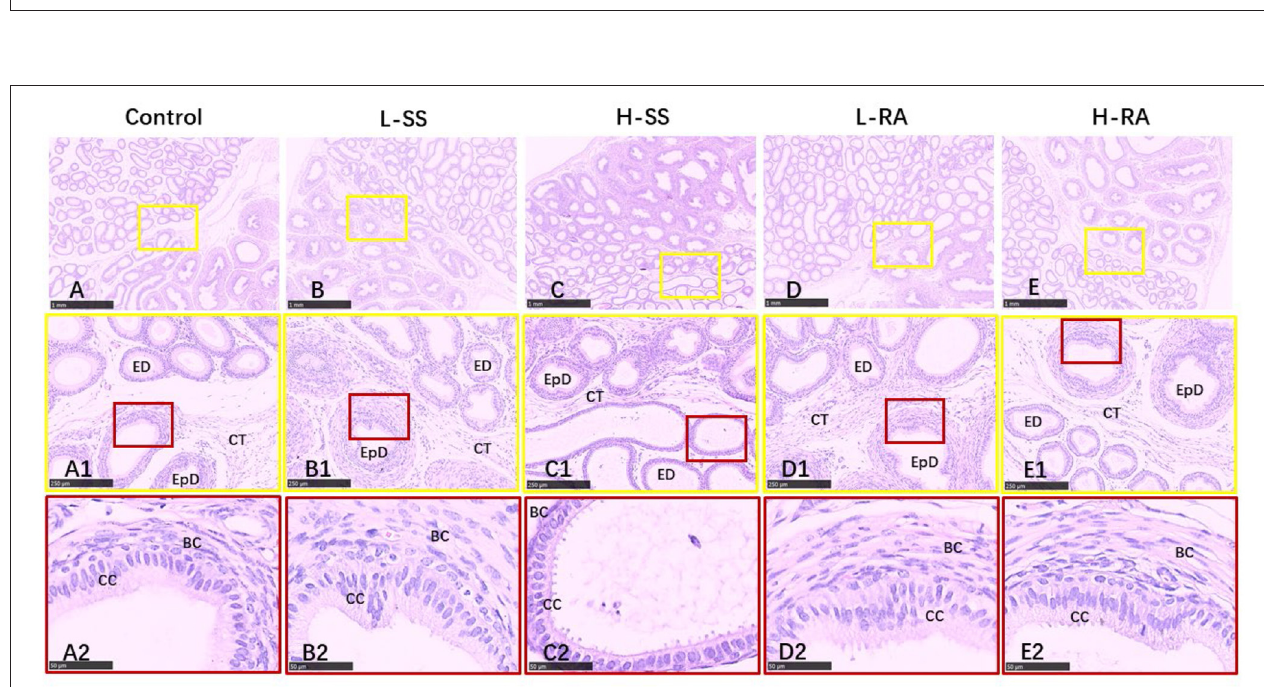
FIGURE 5 | Effect of dietary non-nutritive sweetness drinking on histologic changes in the epididymis in male guinea pigs. Animals in the control, L-SS, H-SS, L-RA, and H-RA groups were supplied water solution with normal water, 1.5mM sodium saccharin, 7.5mM sodium saccharin, 0.5mM rebaudioside A, and 2.5mM rebaudioside A for 28 days, respectively. Tissues were sectioned at 4 µ m and stained with H&E. Graphs in small colored square boxes are enlarged below. ED, efferent duct; EpD, epididymis ductus, CT, connective tissue; CC, ciliated cell; BC, basal cell. Bars = 1,000 µ m (A–E) , 250 µ m (A1–E1) , and 50 µ m (A2–E2) .